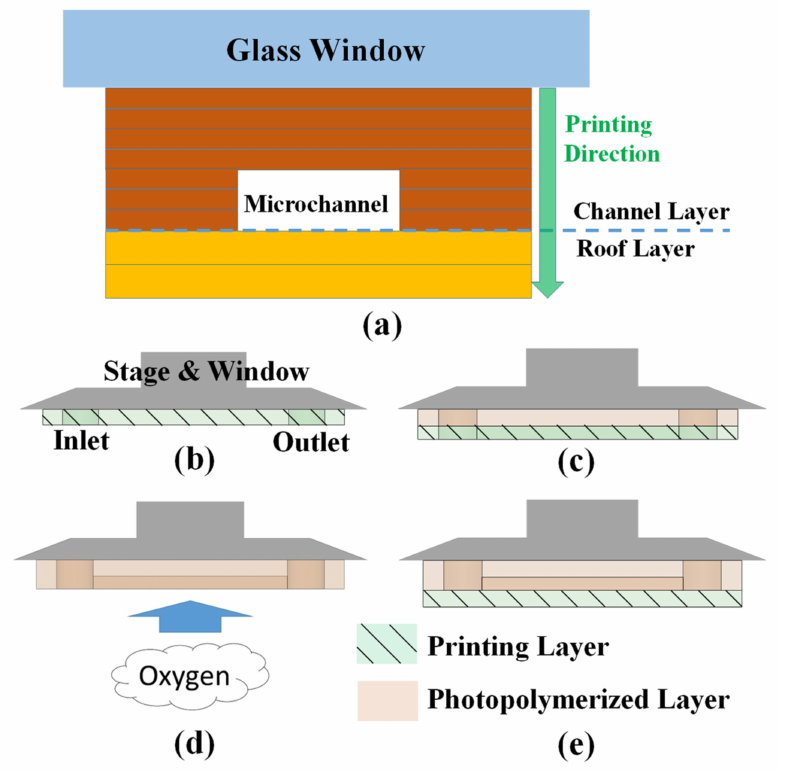
Figure 2. ( a ) Schematic illustration showing a cross-section and the printing process of a monolithic microchannel; ( b – e ) the additive manufacturing process, where the green areas with solid lines indicate a printed layer, and the pink areas indicate a photopolymerized layer; ( b ) substrate printing; ( c ) channel layer printing; ( d ) oxygen introduction step to inhibit the photopolymerization of resin inside the microchannel; ( e ) roof layer printing.